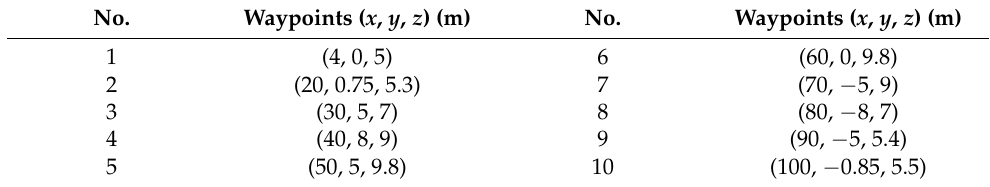
Table 4. Waypoints for Scenario 1.